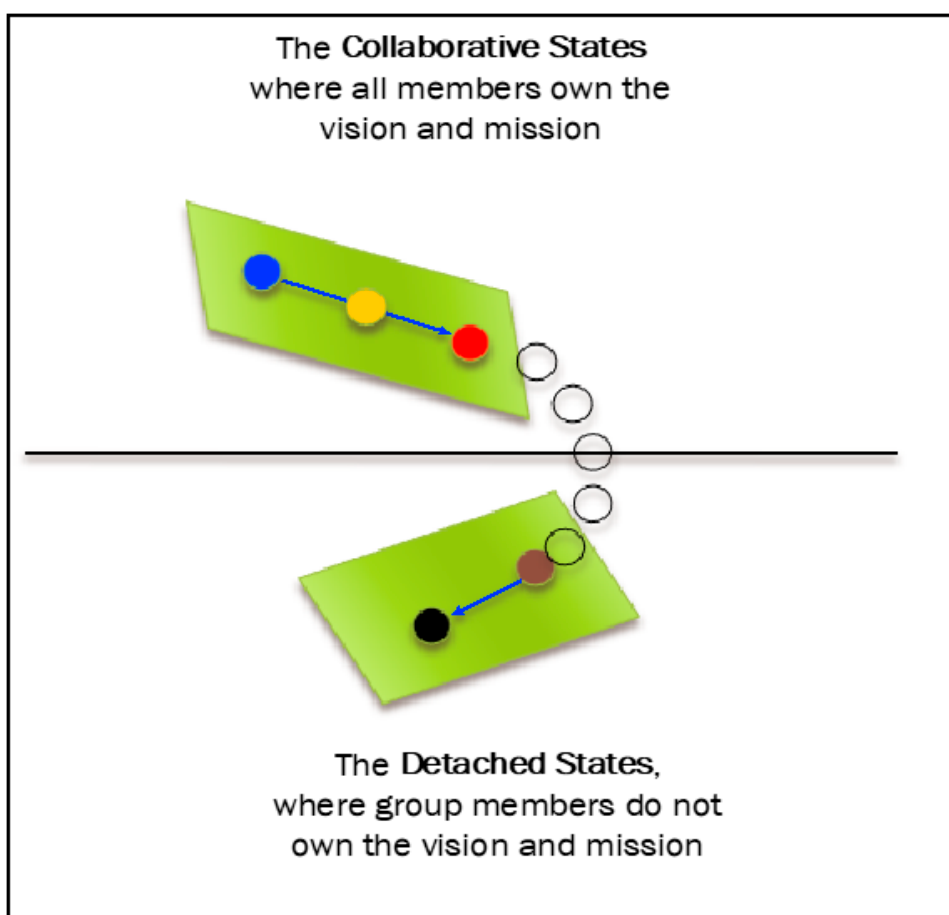
Figure 3. Three-dimensional representation of the fundamental change from collaborative to detached. On the upper trapezoid, the group remains invested in the vision and mission, and that group ownership of the vision and mission underpins the three highest cooperative capacity states. However, there is a fundamental shift when the members of the partnership dissociate from the vision and mission; then, the partnership “falls” off the higher trapezoid to the lower trapezoid (the empty black balls), where this detachment from the vision and mission and absence of shared governance underpins the lowest two cooperative capacity